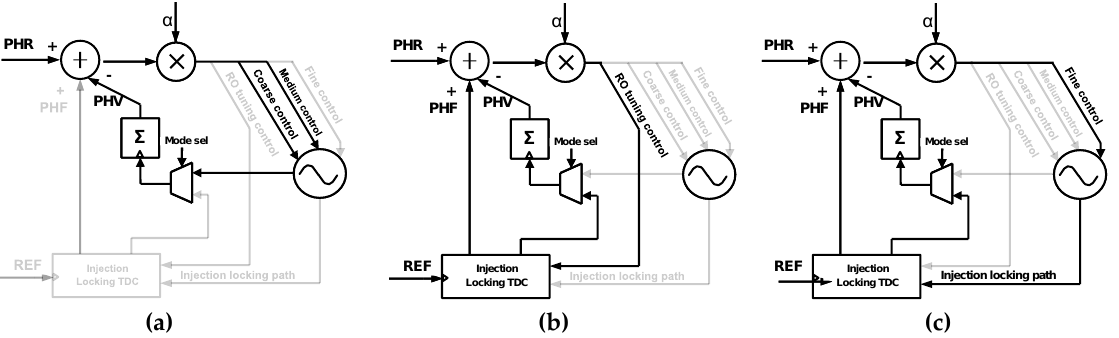
Figure 6. ( a ) Coarse mode and medium mode of the proposed ADPLL; ( b ) RO tuning mode of the proposed ADPLL; ( c ) Fine mode of the proposed